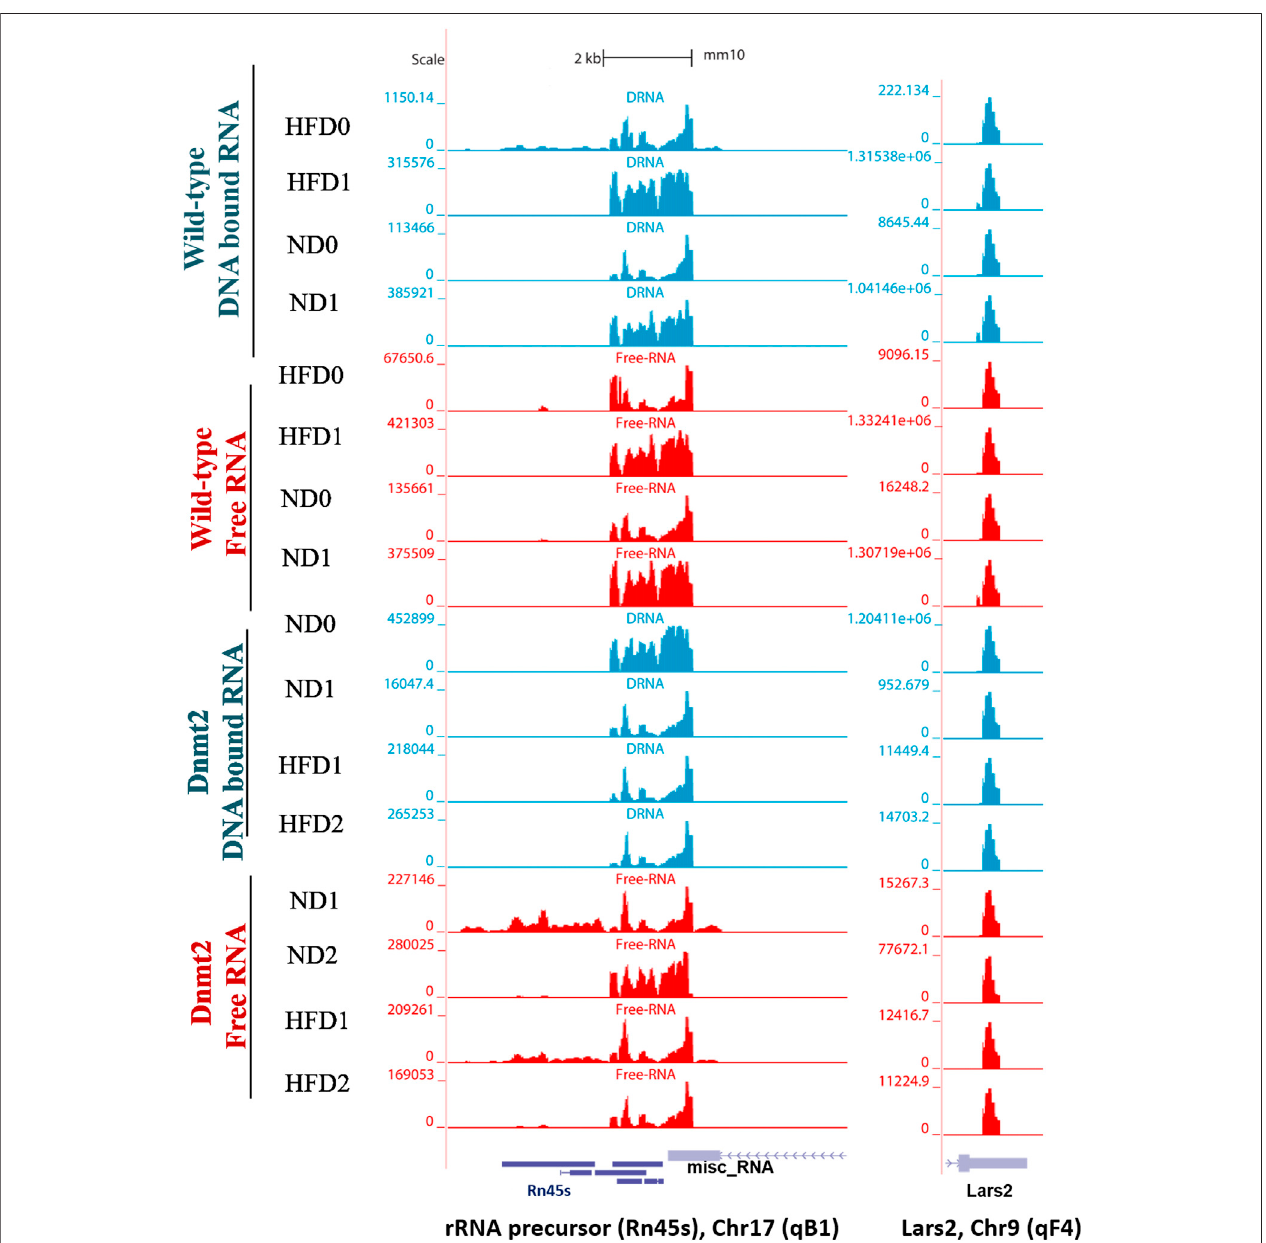
FIGURE 6 | Visualization of highly-expressed signals of DNA-bound and free-RNA moleculees in GRCm38/mm10 in the sperm of wild- type C57BL/6 and Dnmt2-/- mice line in ND and HFD (21% butter, high fat diet). Expression signal tracks of different highly expressed transcripts are visualized which are demonstrated at the bottom of each